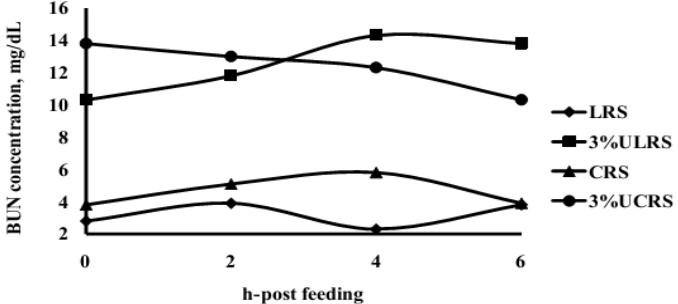
Figure 3. Effect of physical form and urea treatment of rice straw on BUN concentration at 0, 2, 4, and 6 h-post feeding in dairy steers.